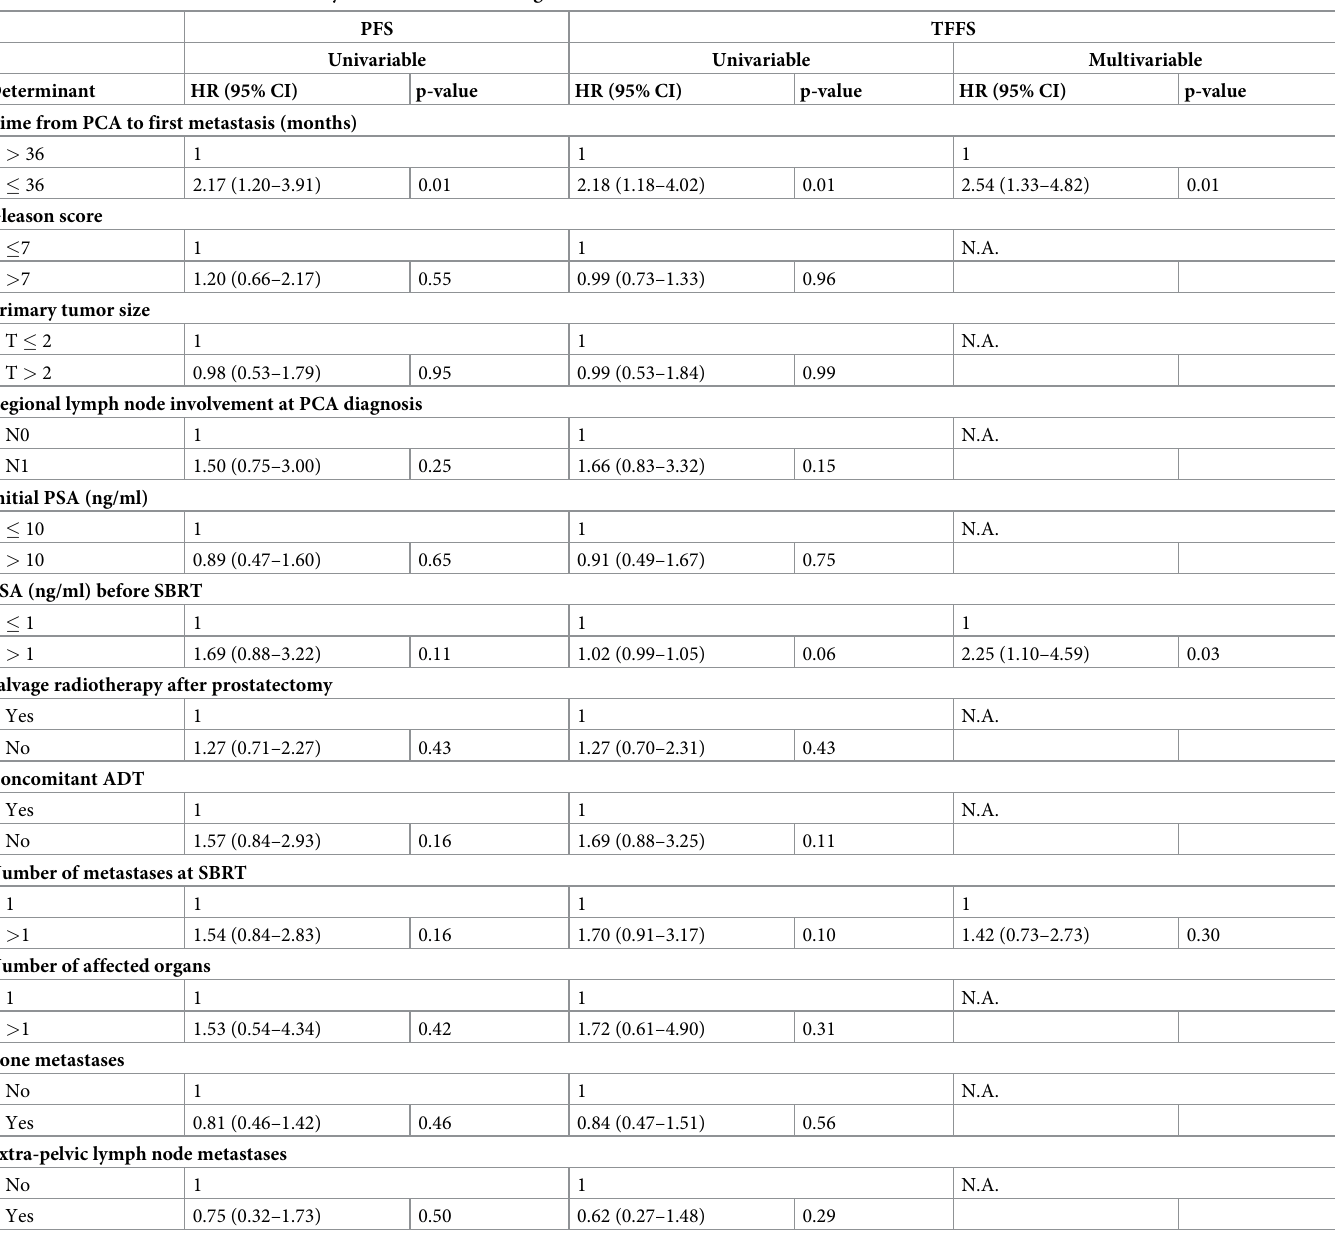
Table 3. Univariate and multivariate analysis of factors influencing PFS and